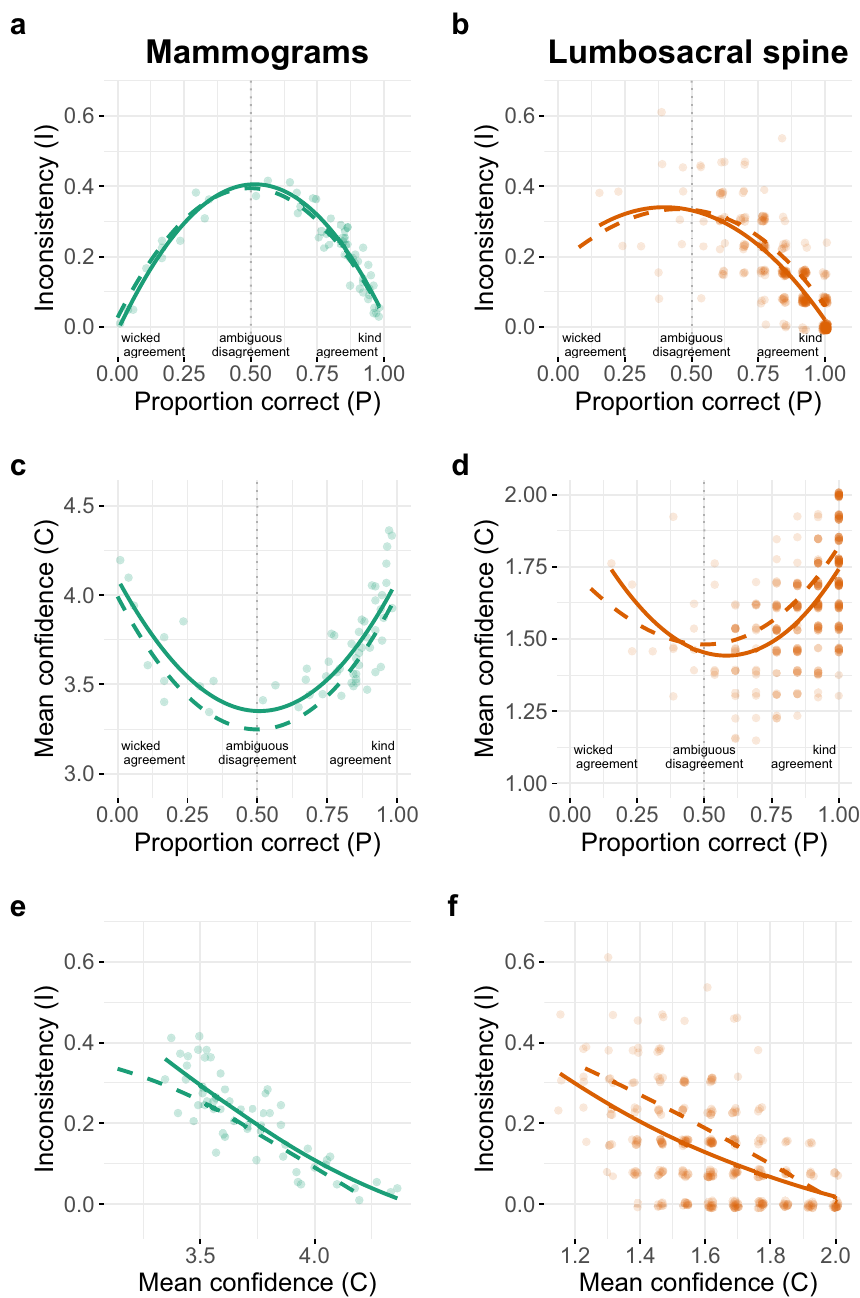
Figure 2. Empirical results on the relationship between the proportion of experts who made a correct diagnosis P ), inconsistency ( I ; probability of making an inconsistent diagnosis), and mean confidence ( C ) in the two ( datasets. (a,b) Inconsistency per case (i.e., proportion of experts who gave two different diagnoses) as a function (cid:31) (cid:31) (cid:31) of the proportion of experts who made a correct initial diagnosis for that case. (c,d) Mean confidence in the initial diagnosis per case as a function of the proportion of experts who made a correct diagnosis for that case. In the mammography dataset (c) , confidence was elicited on a 5-point rating scale (1: “not at all confident”, 2: “not very confident”, 3: “neutral”, 4: “confident”, 5: “very confident”). In the spine dataset (d) , confidence was elicited on a 2-point scale (1: low confidence, 2: high confidence). (e,f) Inconsistency per case as a function of its P and C from initial diagnoses (i.e., mean confidence. Each dot represents one case and its coordinates represent from the first rating session in the respective dataset); the solid curves are LOESS smooths across those points. (cid:31) (cid:31) P and C from the second diagnoses (i.e., from the second The dashed curves show the smooths when using rating session in the respective dataset); to avoid overplotting, the corresponding dots for the individual cases (cid:31) (cid:31) are not shown. (b,d,f) Employ jittering to avoid